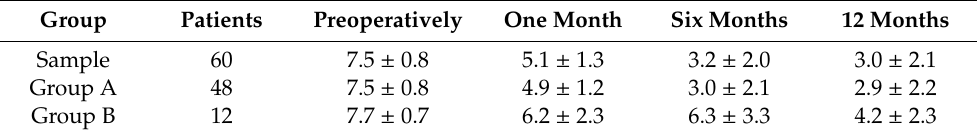
Table 2. VAS score results at preoperatively, one, six, and 12 months after treatment. Group